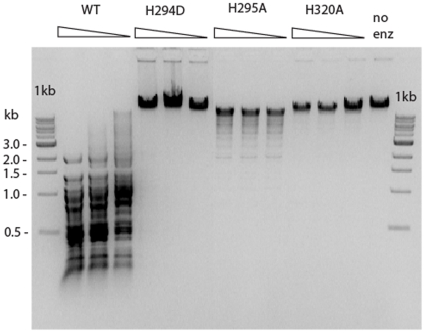
DNA cleavage activity of the catalytic residue mutants.Purified protein of WT, H294D, H295A and H320A were assayed as described in Materials and Methods in the presence of 2 mM NiSO4. Five μl of undiluted, three-fold and nine-fold dilutions of 1.5 mg/ml of enzyme solution were assayed on 1 µg of λ DNA.